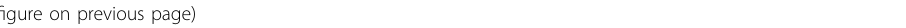
Fig. 6 mascRNA and MALAT1 active ERK/MAPK signaling pathway in HCC. A The expressions of MAPK1 and MAPK3 were detected by real-time RT-PCR in control and shMALAT1 HepG2 stable cell lines. Western blotting for ERK and p-ERK in ( B ) HepG2 and ( C ) Bel7402 control and shMALAT1 stable cells. D Western blotting for JNK, p-JNK, P38, p-P38 in HepG2 control and shMALAT1 stable cells. Western blotting for ( E ) JNK, p-JNK, F P38, p-P38 in Bel7402 control and shMALAT1 stable cells. The activity of ERK signaling was examined by the dual-luciferase reporter assay in ( G ) HepG2 and ( H ) Bel7402 control and shMALAT1 stable cells. I The expressions of MAPK1 and MAPK3 were detected by real-time RT-PCR in control and mascRNA overexpressed HepG2 stable cell lines. Western blotting for ERK and p-ERK in ( J ) HepG2 and ( K ) Bel7402 control and mascRNA overexpressed stable cells. The activity of ERK signaling was examined by the dual-luciferase reporter assay in ( L ) HepG2 and ( M ) Bel7402 control and mascRNA overexpressed stable cells. All western blotting in this fi gure used GAPDH as a control. The band density of ERK, p-ERK, JNK, p-JNK, P38, and p-P38 were normalized to respective GAPDH, and the values of p-ERK/ERK, p-JNK/JNK, and p-P38/P38 were showed in the fi gure. Quantitative data were represented as mean ± SD. * P < 0.05, ** P <